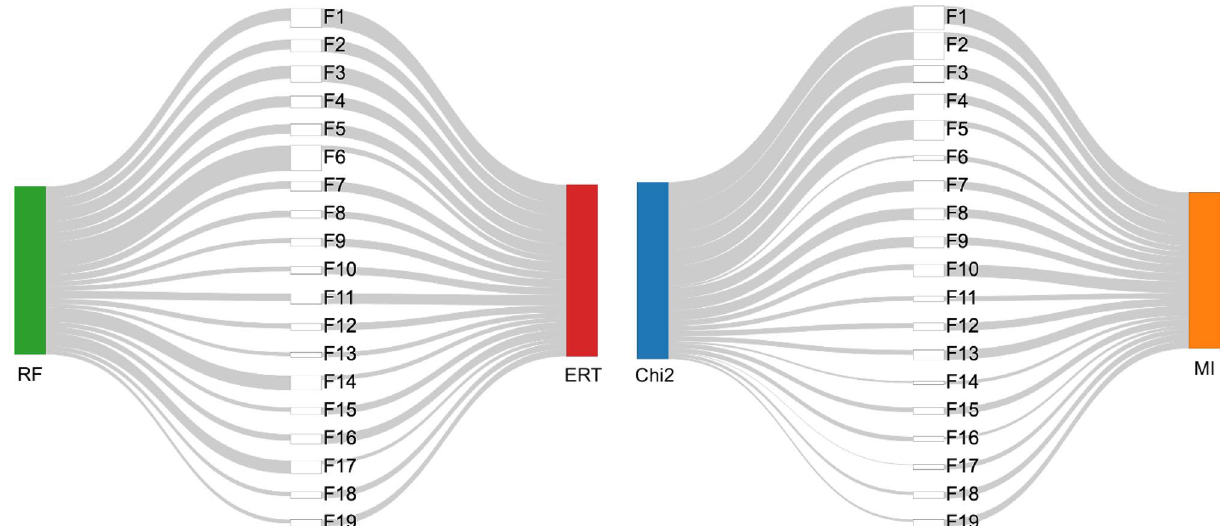
Figure 5. Feature contribution to the four models. In this graph, the thickness of the grey lines indicates how much the feature impacts the results obtained by the model. For legend on the models, see Fig. 3, for the description of the features, see Table 1.